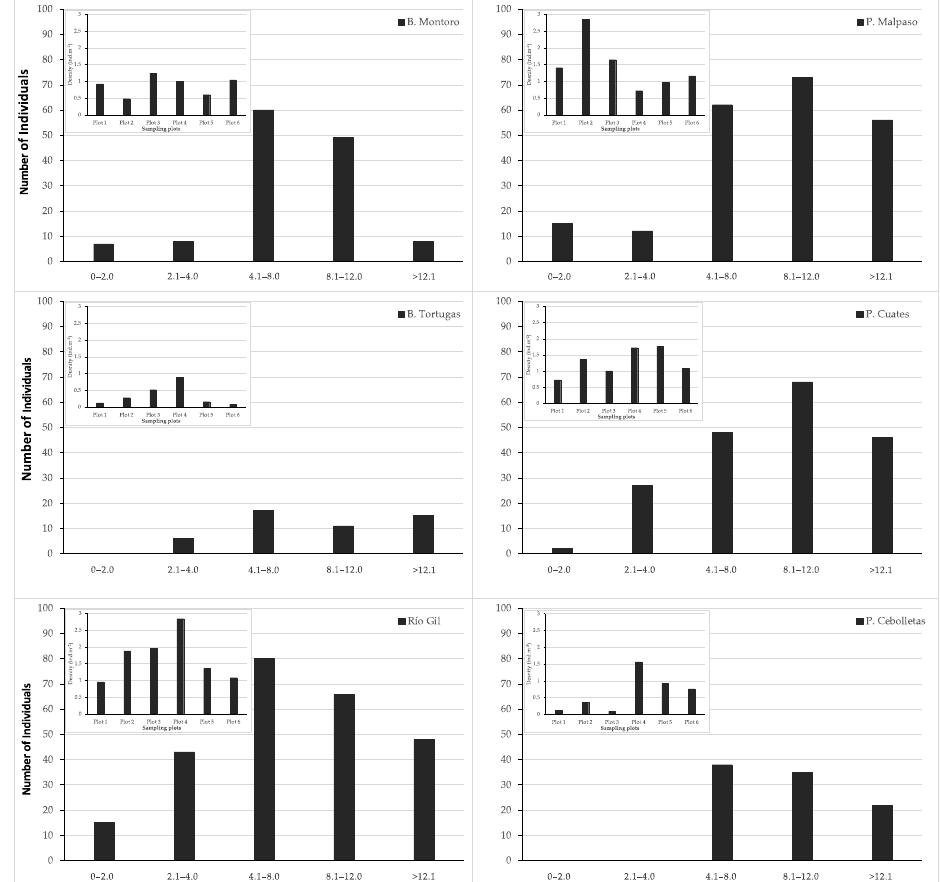
Figure 3. Population size structure, and density (embedded graph) per sampling site. The population of Barranca Tortuga (0.34 ± 0.28 ind m − 2 ), Barranca Montoro (0.88 ± 0.26 ind m − 2 ), and Presa Cebolletas (0.63 ± 0.51 ind m − 2 ) showed a lower density compared with the sites of Presa Malpaso (1.45 ± 0.68 ind m − 2 ), Puente Cuates (1.27 ± 0.38 ind m − 2 ) and Río Gil (1.68 ± 0.64 ind m − 2 ). These three populations showed more remarkable cover